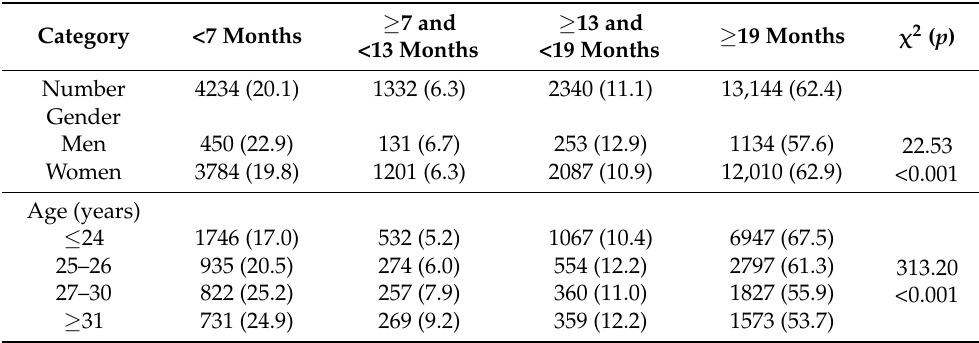
Table 3. Differences between the retention periods of newly hired nurses according to general characteristics ( n =